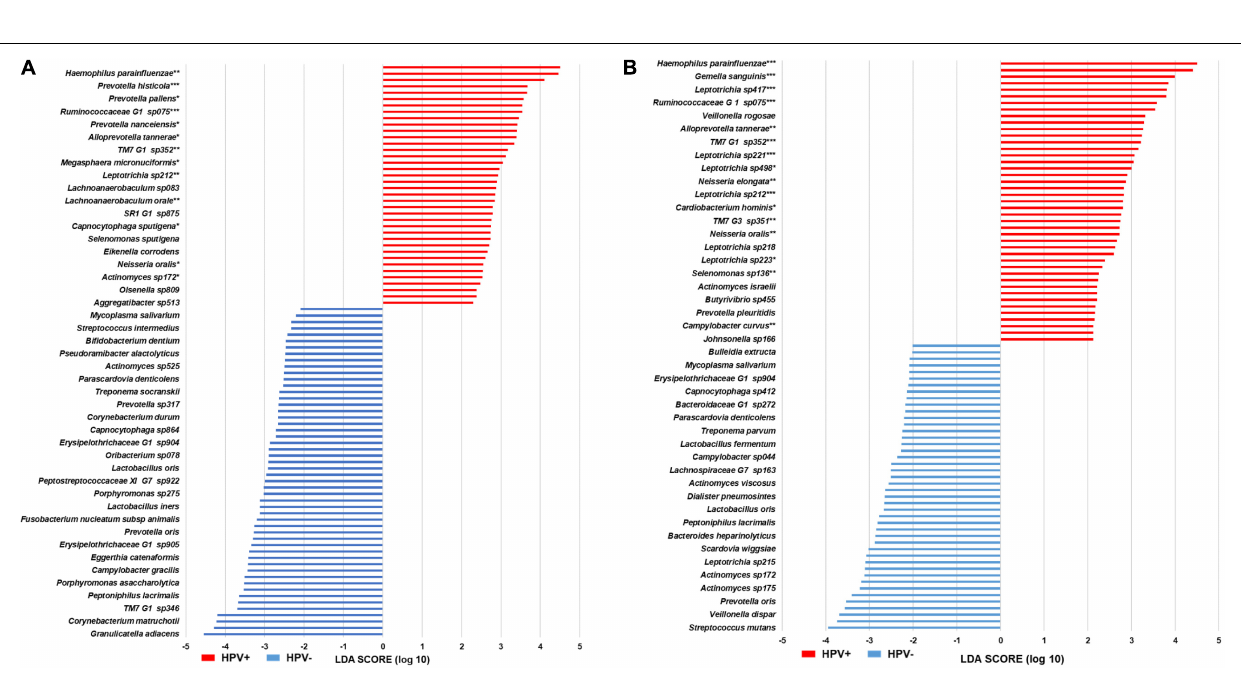
FIGURE 3 | LEfSe histograms of differential features in head and neck cancer patients. (A) Grp-All BPST. (B) Grp-noAB BPST. Linear discriminant analysis Effect Size (LEfSe) was performed to determine distinct microbiome features in oral samples [stimulated saliva (S) samples and swabs of buccal mucosa (B), supragingival plaque (P), and tongue (T)] of the following: (A) Grp-All patient cohort ( N = 23) for the head and neck cancer (HNC) HPV-positive (HPV+; N = 16) vs. HPV-negative (HPV–; N = 7) comparisons. (B) Grp-noAB patient cohort ( N = 15) for HNC HPV+ ( N = 12) vs. HPV– ( N = 3) that did not receive antibiotics within 2 weeks of sampling. Horizontal histograms depict the discriminant features, i.e., bacterial species, for Grp-All and Grp-noAB potential biomarkers for HPV+ (red) and HPV– (blue). Mann–Whitney U -tests were used to determine significance of HPV+ distinctive species. Level of significance is depicted by an asterisk (*): * p < 0.05; ** p < 0.01; *** p <